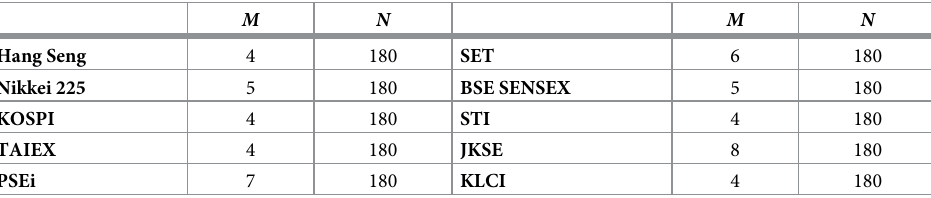
Table 2. The best combination of M and N in the training